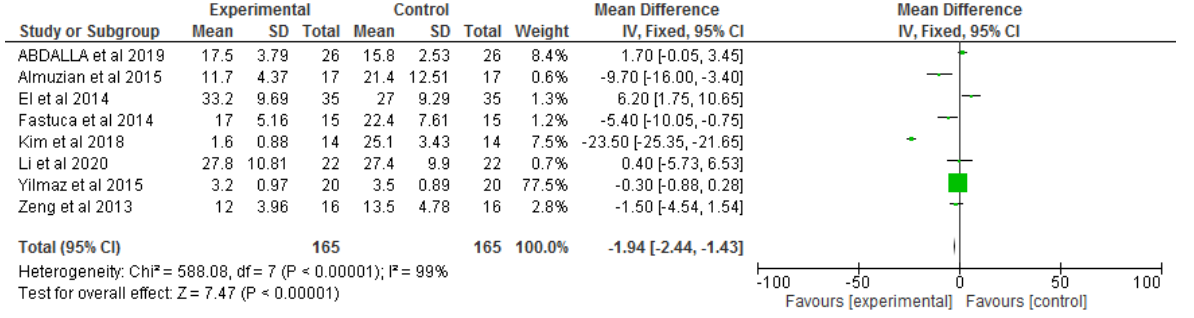
Figure 11. Funnel plot for maxillary expansion between experiment and control. 3.4.6. Surgery Class III Three studies report the Meta analysis for surgery class III between the pre- and post- surgical group. The pooled analysis showed a significant effect on surgery class III be- tween the pre- and post-surgical group (MD = 3.45, CI 2.54, 4.35; Chi 2 = 7.60; I 2 = 74%, p < 0.0001). Heterogeneity between the three studies is high (I 2 = 74%). Test for overall effect: Z = 7.48 ( p = 0.0001) (Figures 12 and 13). Figure 12. Forest plot for Surgery class III between pre and post surgery.